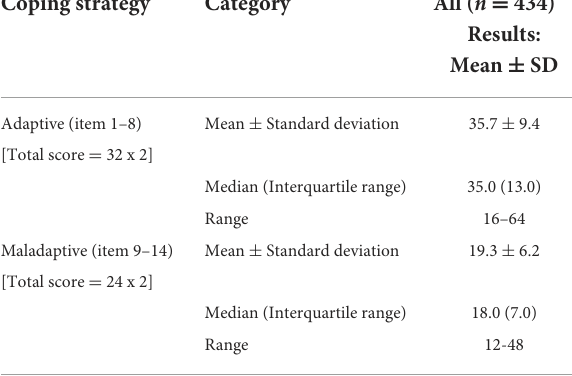
TABLE 4 Aggregate scores for adaptive and maladaptive coping